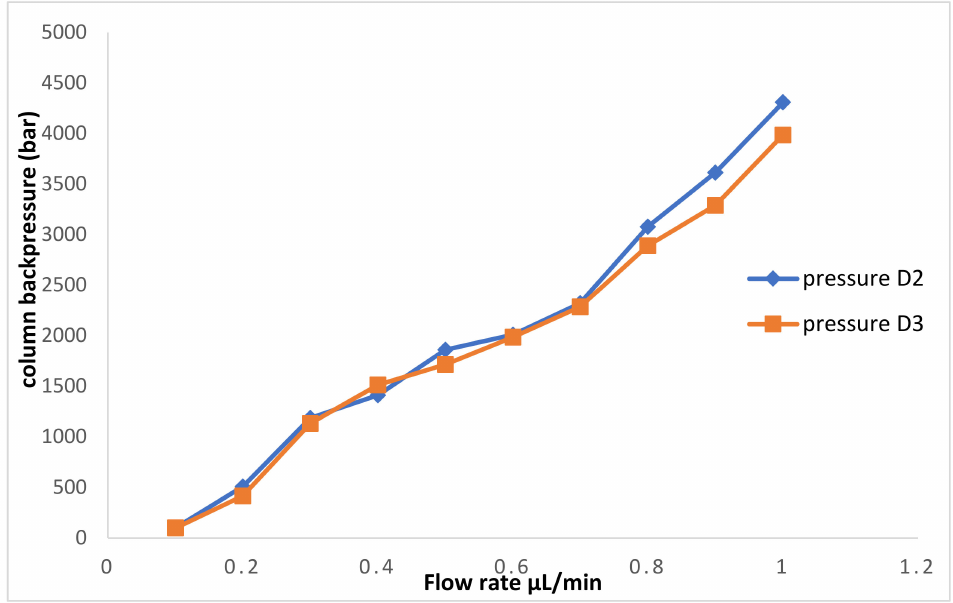
Figure 5. Column backpressure versus mobile phase flow rate of daptomycin monolithic columns, mobile phase: methanol/water 80:20 ( v/v